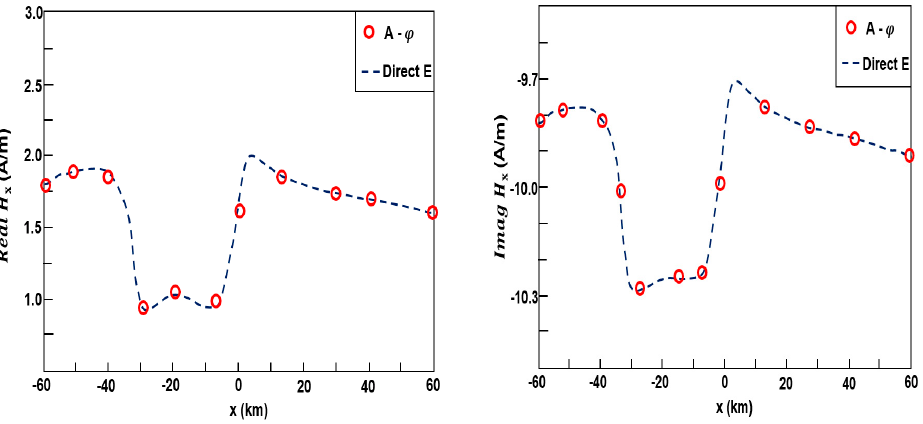
Figure 11. The plot of the real and imaginary component for the magnetic field of the E y polarization calculated using the Potential and Direct E formulation.